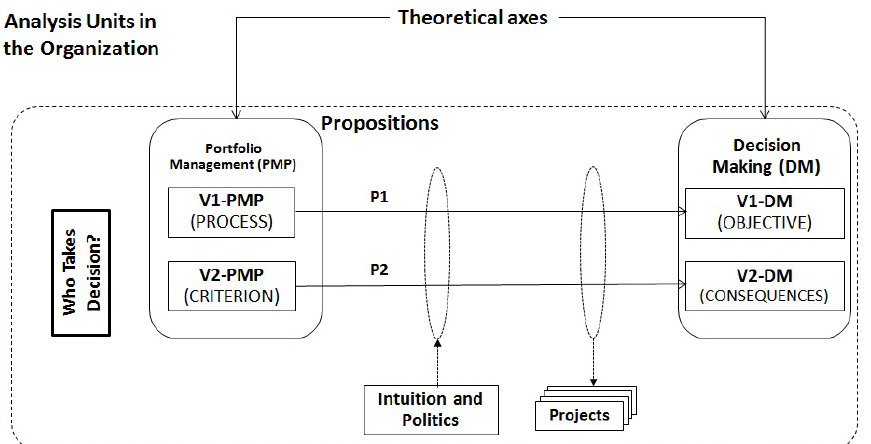
Figure 4. Conceptual Model of the Case